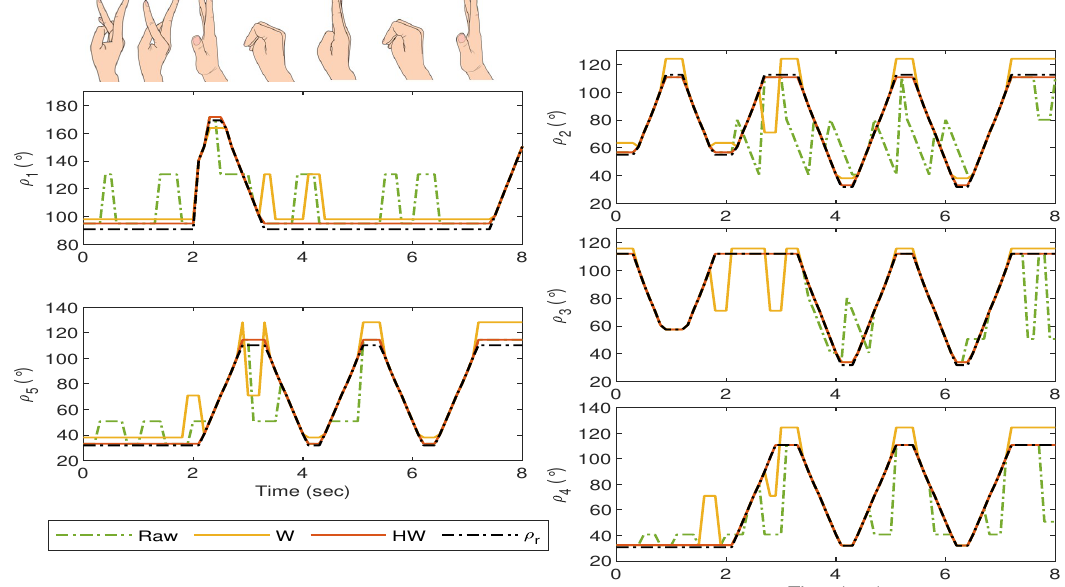
Figure 23. Gesture 6: The mismatch between the glove’s and bionic hand’s goniometry is minimal when Compensator HW is applied as compared to the